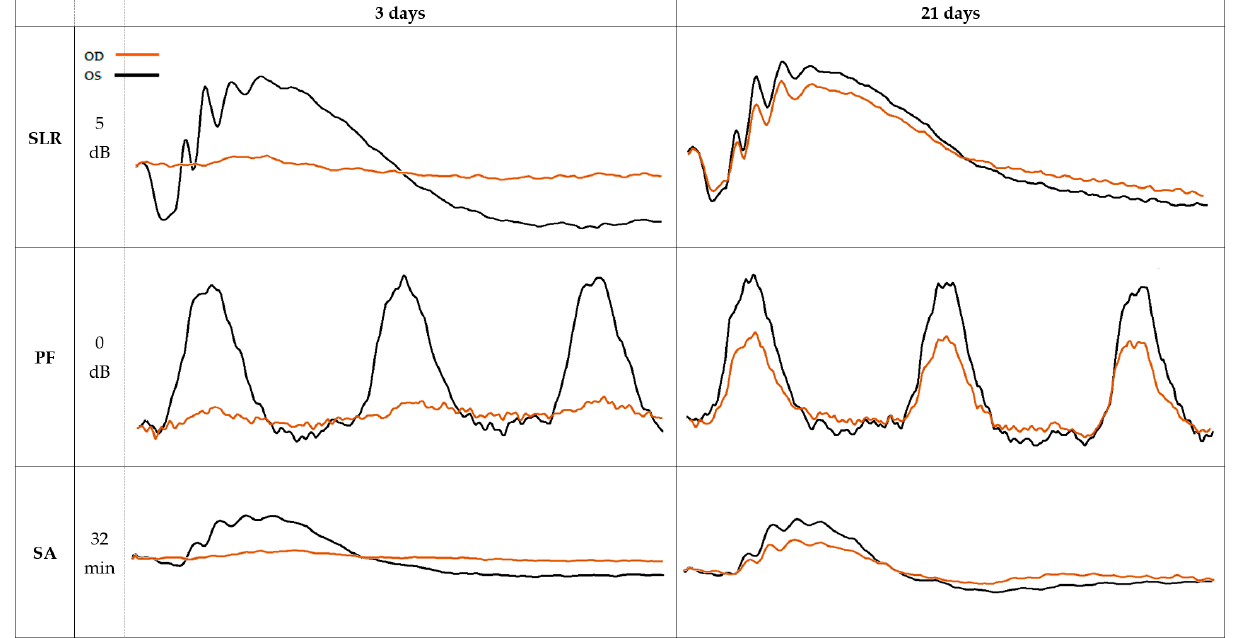
Figure 4. ERG waveforms of the OD (orange) and the OS (black) recorded at day 3 and day 21 after the glaucoma induction, from the treatment group. SLR, scotopic luminescence response; PF, photopic flicker; SA, scotopic adaptation; OD, right eye; OS, left eye.